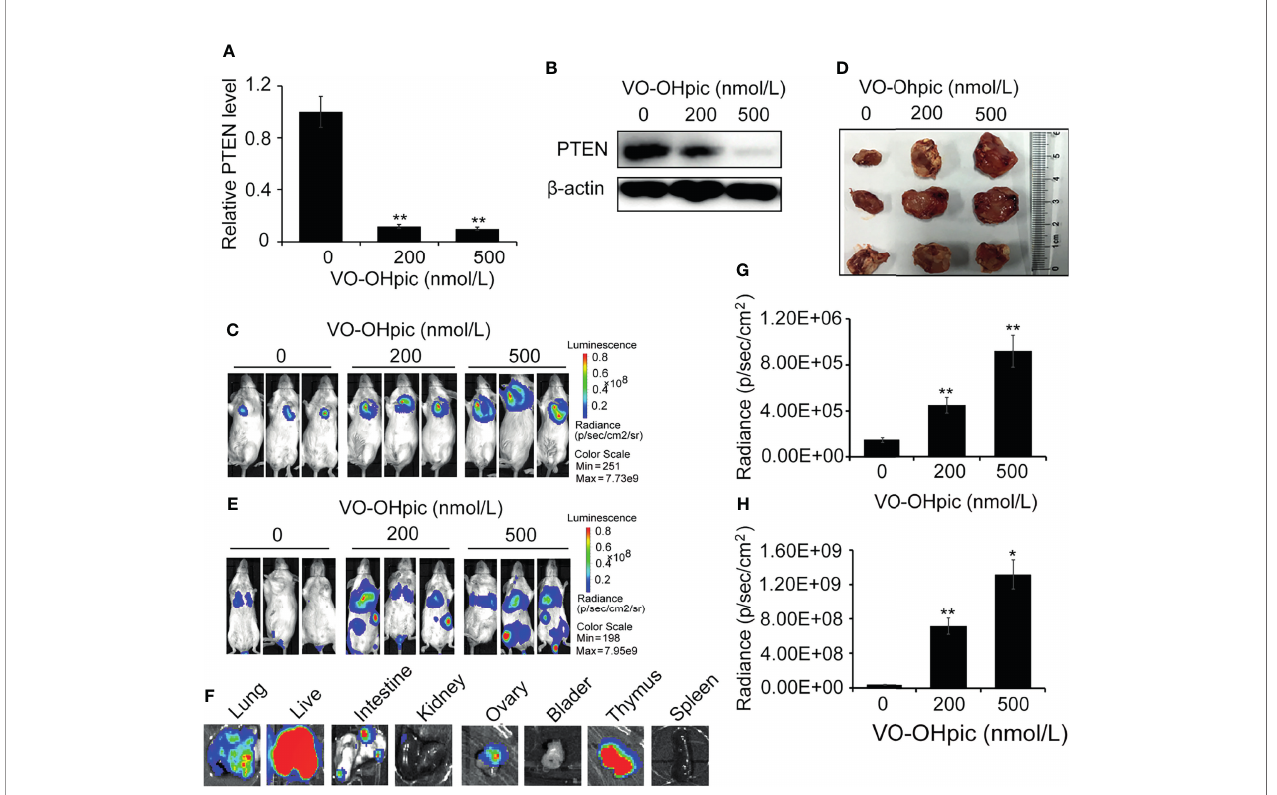
FIGURE 3 | Inhibition of PTEN promoted the growth of orthotopic breast tumors and organ metastases and colonization in mice. PTEN gene (A) and protein (B) levels in 4T1-luc cells were decreased after treatment with 200 or 500 nmol/L VO-OHpic for 2 h. The above cells were inoculated into the breast fat pad of Balb/c mice to establish an in situ tumor model (C) and dissected tumor tissues were imaged at 10 days (D) . Tumor metastasis models (F) were established by injection of the above cells via the tail vein, and visceral tumor metastasis was observed at 14 days. Cellular PTEN inhibition by VO-OHpic signi fi cantly increased the counts of bioluminescent photons in situ breast tumors (E) and visceral metastases (G) . (H) Bioluminescence of some visceral metastases. Compared with 0 nmol/L VO- OHpic group, * P <0.05, ** P